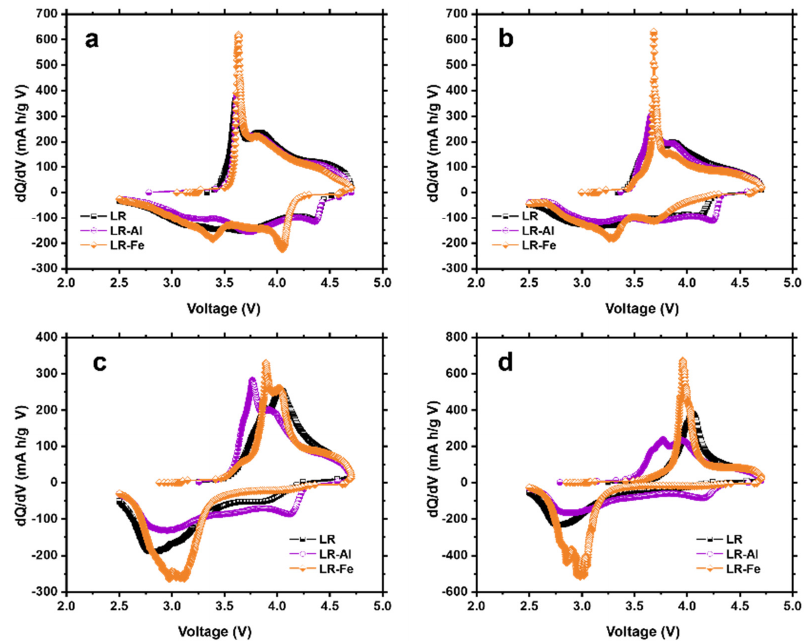
Figure 9. dQ/dV plots for ( a ) 2, ( b ) 25, ( c ) 75, and ( d ) 100